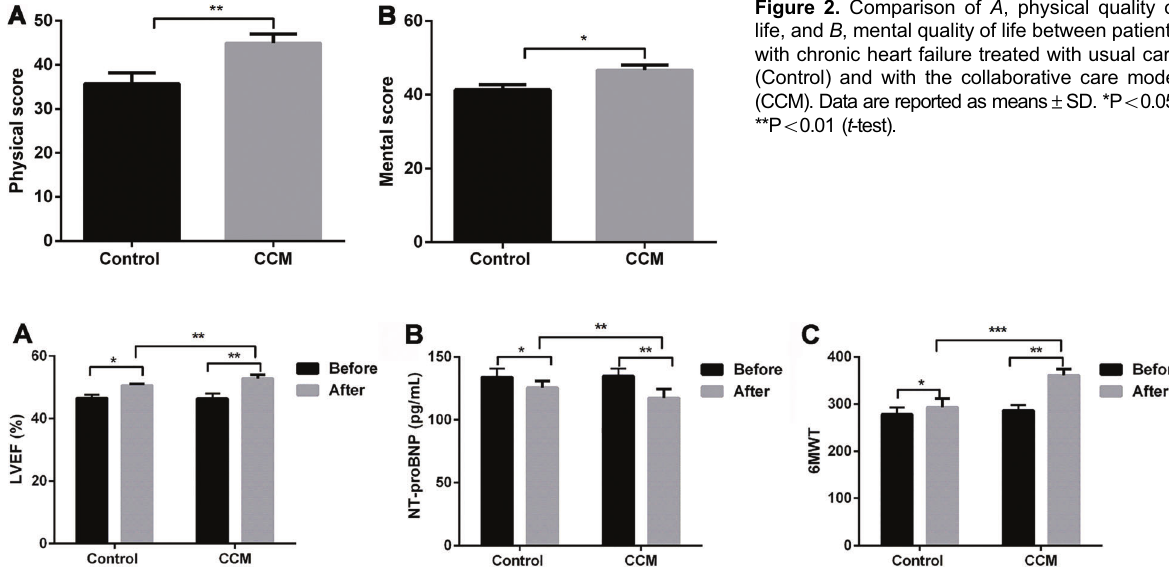
Figure 3. Comparison of A , left ventricular ejection fraction (LVEF); B , N-terminal pro-B-type natriuretic peptide (NT-proBNP) level, and C , exercise capacity between patients with chronic heart failure treated with usual care (Control) and with the collaborative care model (CCM). 6MWT: 6-min walking test. Data are reported as means ± SD. *P o 0.05; **P o 0.01; ***P o 0.001 ( t